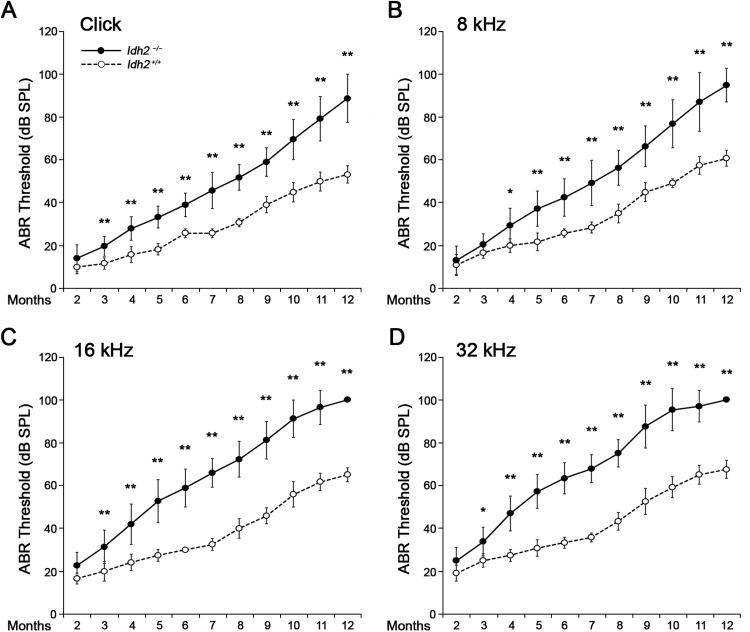
ABR hearing thresholds of theIdh2+/+andIdh2−/−mice as a function of age. The changes in the hearing threshold of Idh2+/+ (white circle with dotted line, n = 6) and Idh2−/− (black circle with solid line, n = 18) mice were represented using line graphs. The ABR thresholds were measured for 12 months with a click (A) and tone burst (8, 16, and 32 kHz) (B, C and D) stimuli. Data are shown as the means ± SEM. *p < 0.05, **p < 0.005.